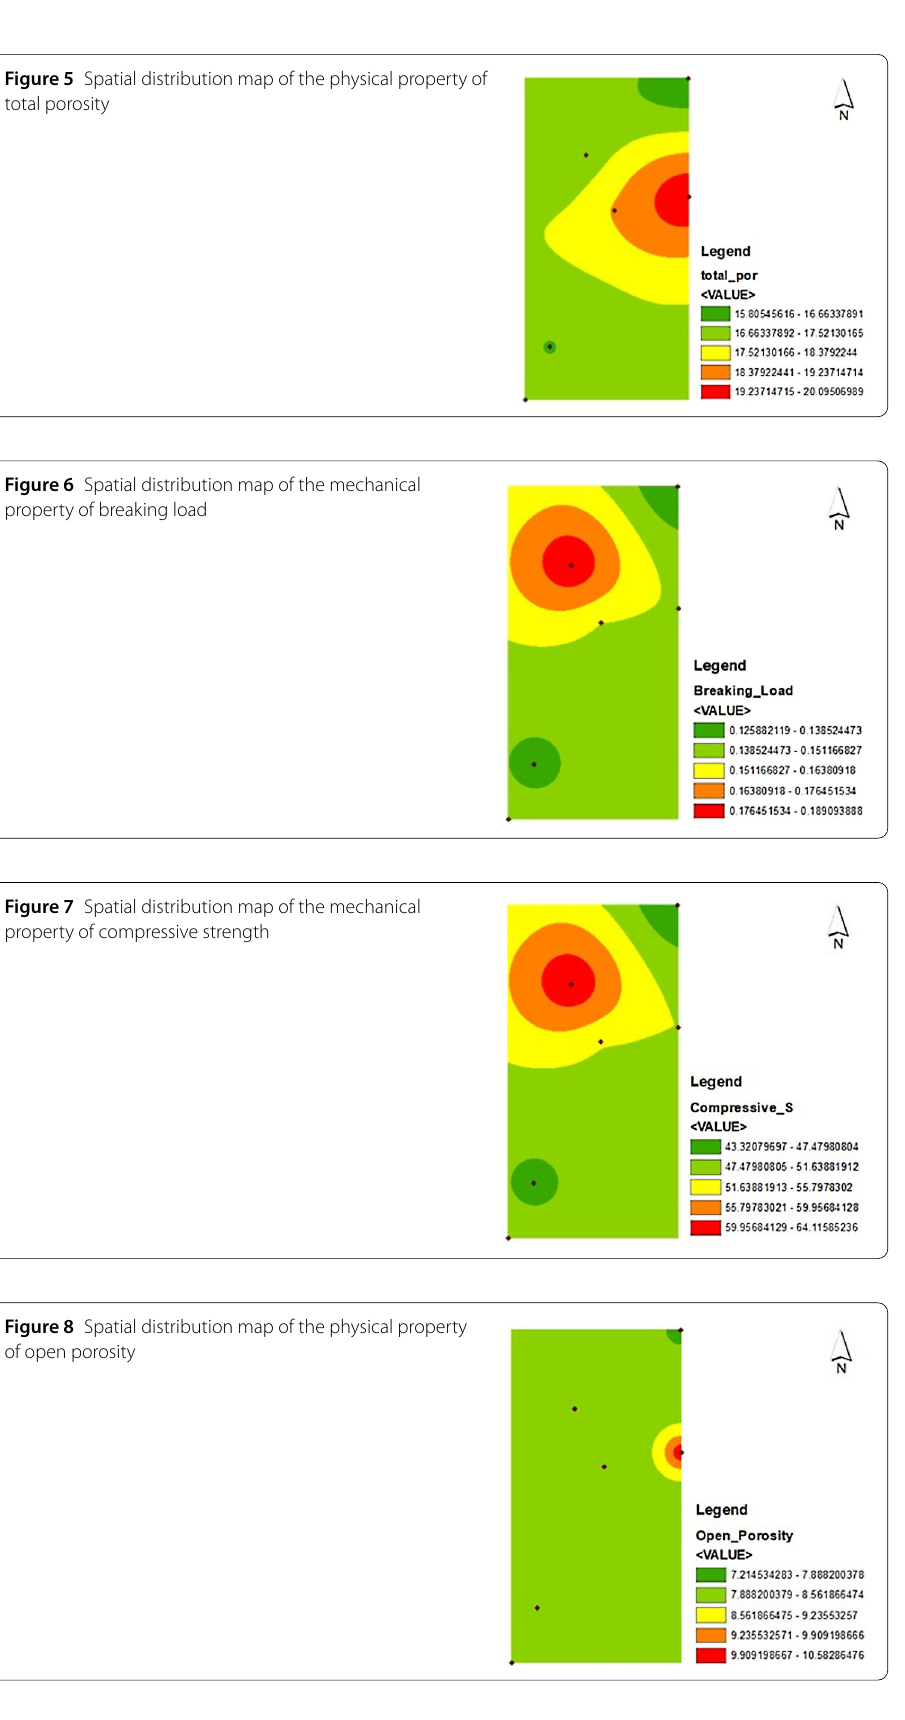
Figure 6 Spatial distribution map of the mechanical property of breaking load